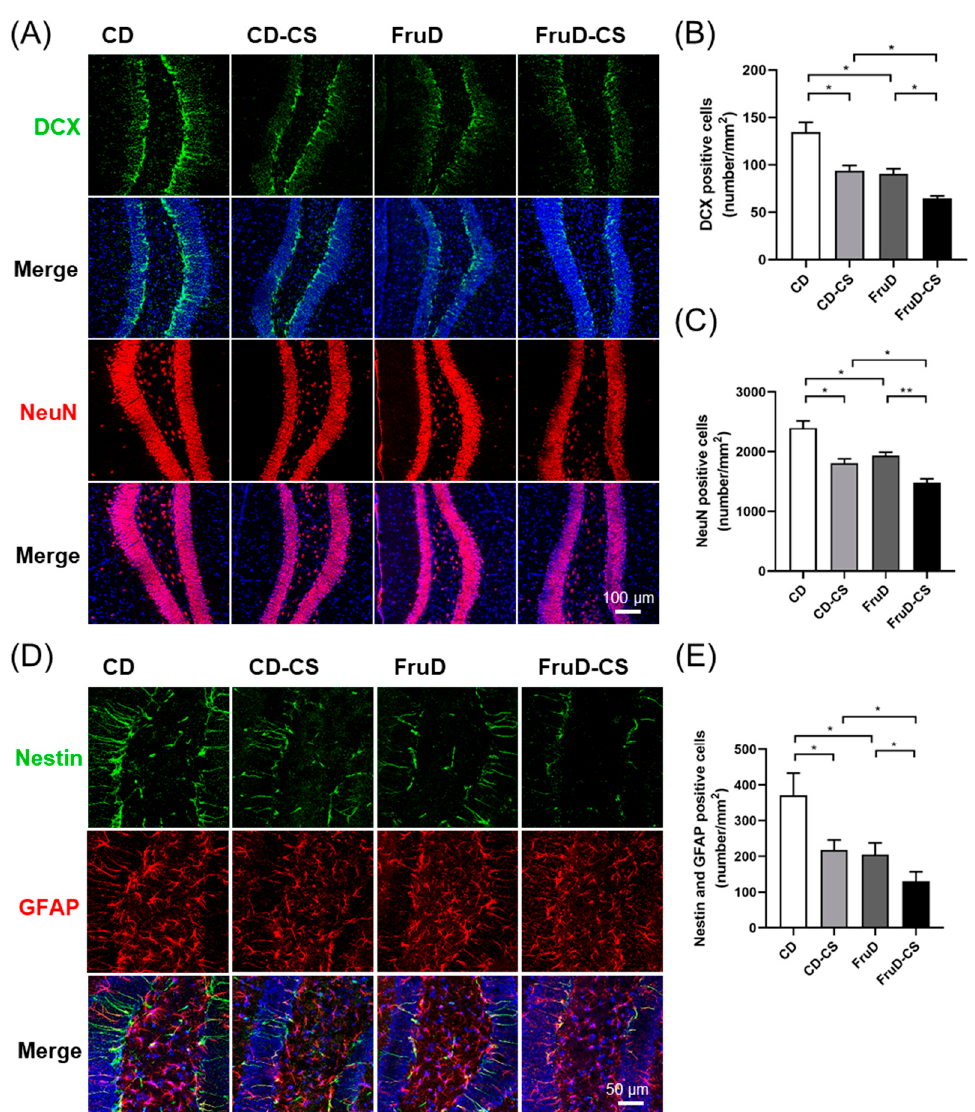
Figure 2. Chronic stress worsens the decline of hippocampal neurogenesis in FruD mice. ( A ) Representative confocal images labeled with DCX or NeuN. ( B ) Number of DCX positive newborn neurons was quantified. ( C ) Number of NeuN positive mature neurons was quantified. ( D ) Representative confocal images labeled with Nestin and GFAP. ( E ) Number of Nestin and GFAP positive NSCs was quantified. Data are expressed as mean ± SEM, * p < 0.05, ** p < 0.01.